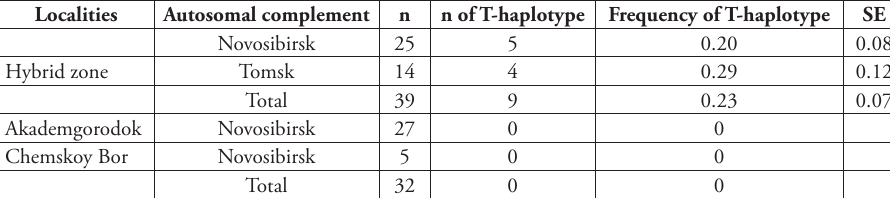
Table 1. Frequency of the Y chromosome variants in the studied races.